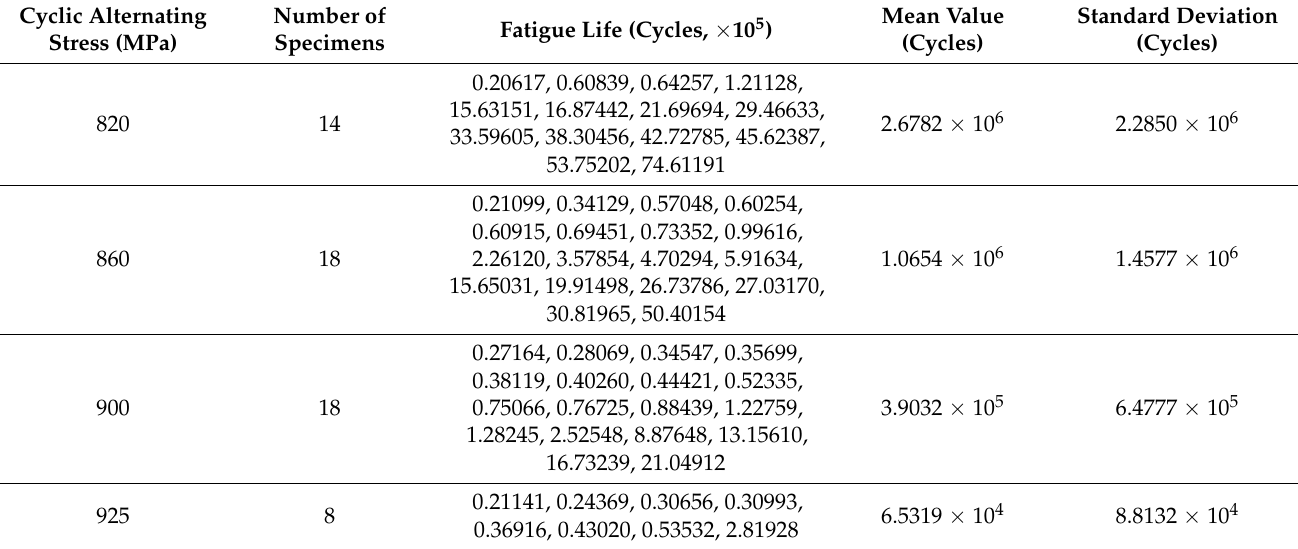
Table 1. The test data of Ti-6246 alloy.